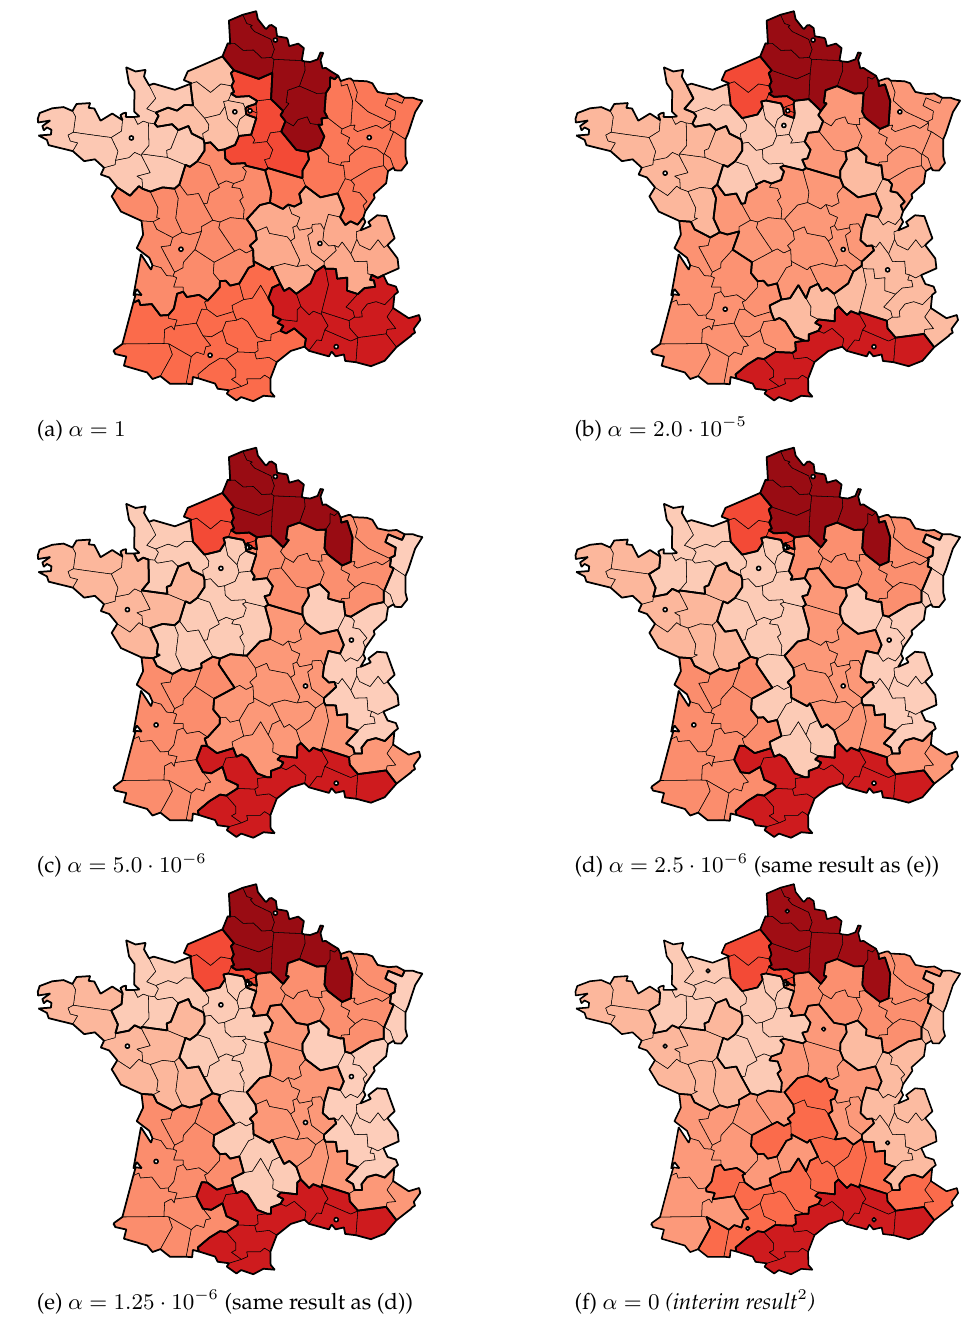
Figure 10: Output with w min equaling 10 % of France’s total population; thick lines mark aggregated regions colored according to the unemployment rate of their center ( ◦